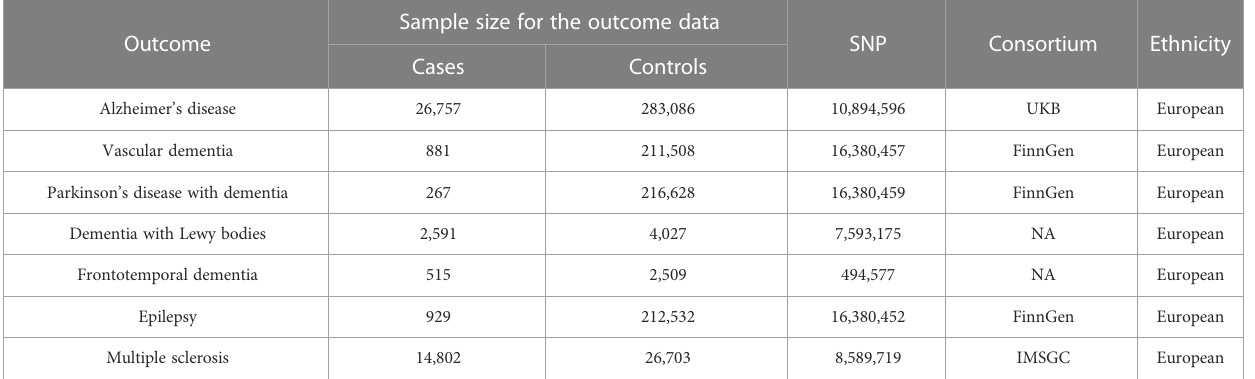
TABLE 1 The characteristics of genome-wide association studies on outcome.